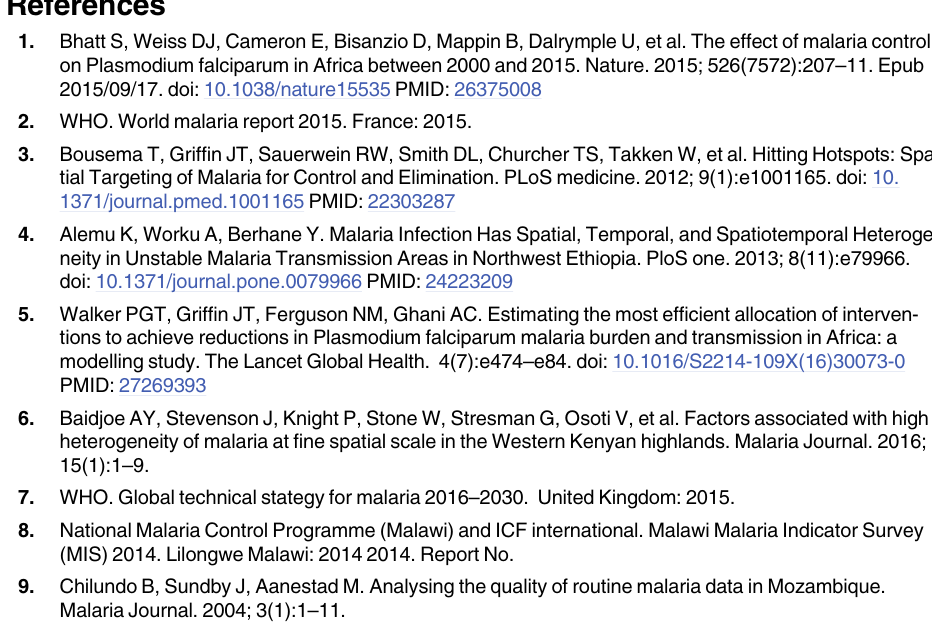
S1 Table. Parameter estimates from non-spatial probit model for malaria prevalence in children 6–59 months. ITN: insecticide treated bed nets, NDVI: normalized difference vegeta- tion index, SES: socio-economic